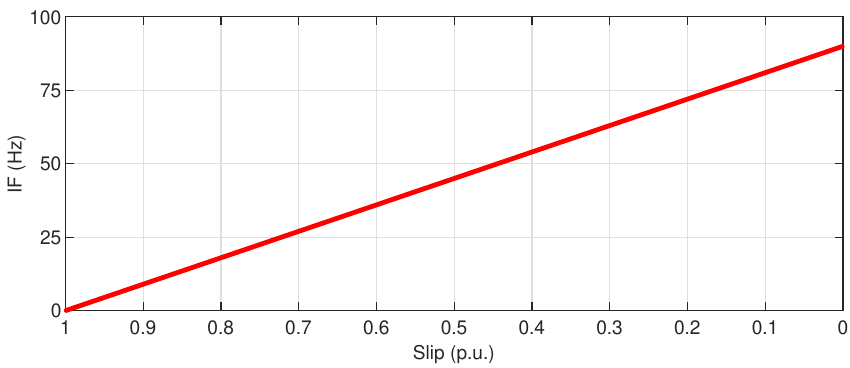
Figure 21. Theoretical evolution of the IF of the outer race fault components in the envelope of the start-up current.